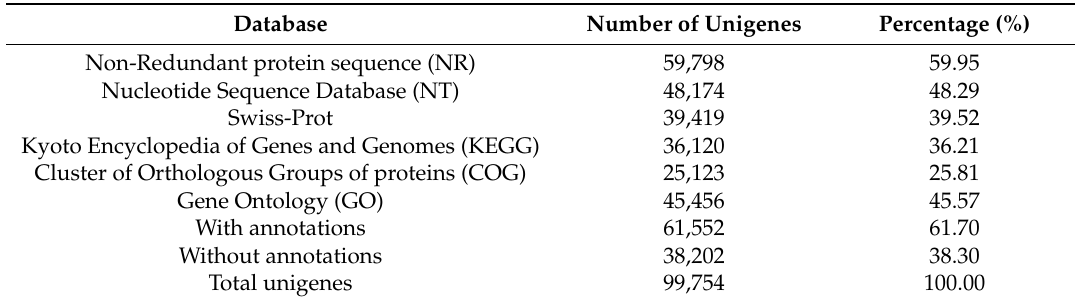
Table 1. Numbers of unigenes functionally annotated with different